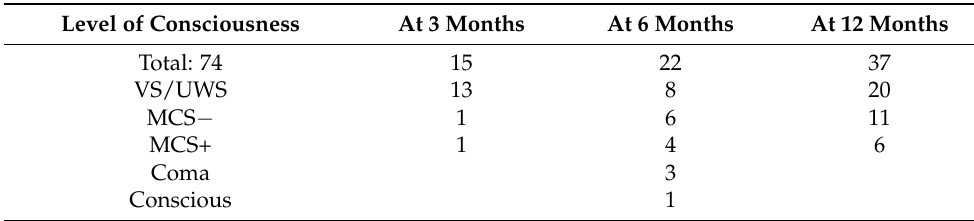
Table 3. Mortality within first year after brain injury. Level of Consciousness